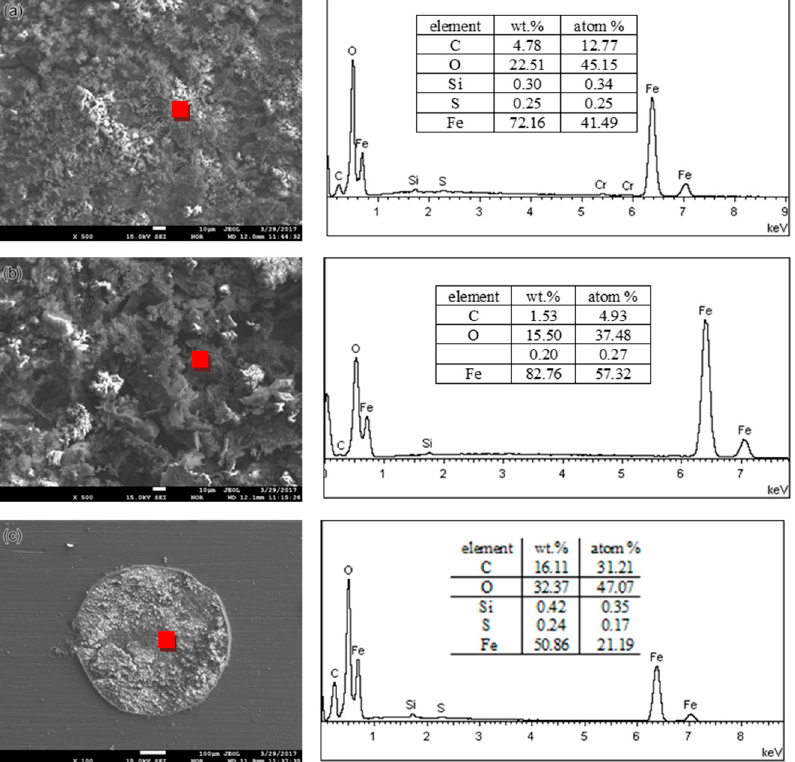
Figure 8. EDS analysis results of corrosion products: ( a ) full immersion, ( b ) half immersion and ( c ) high-pressure gas exposure.